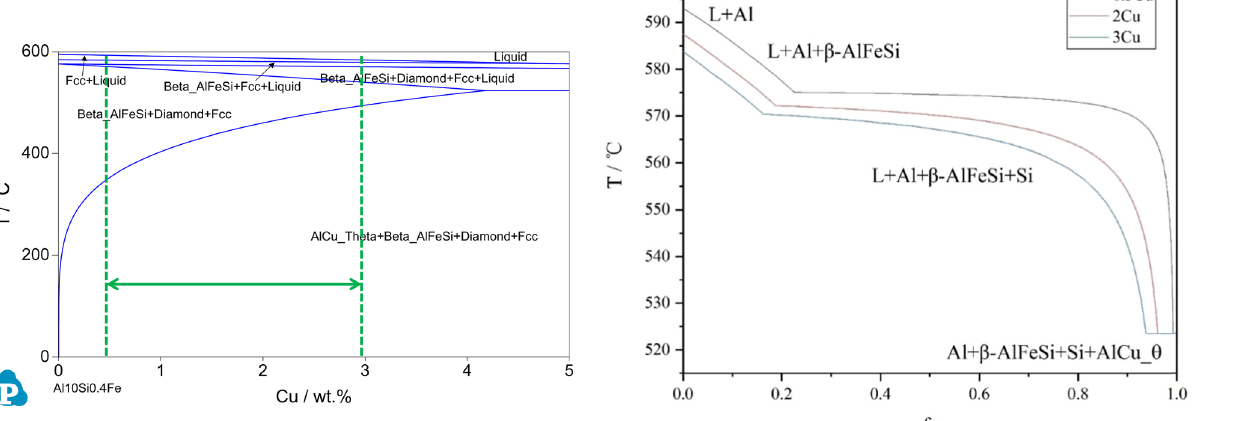
Figure 12: Calculation results of nonequilibrium solidi fi cation path 9 Fe 2 Si 2 , and AlCu_Theta is of Al10Si0.4Fe - Cu